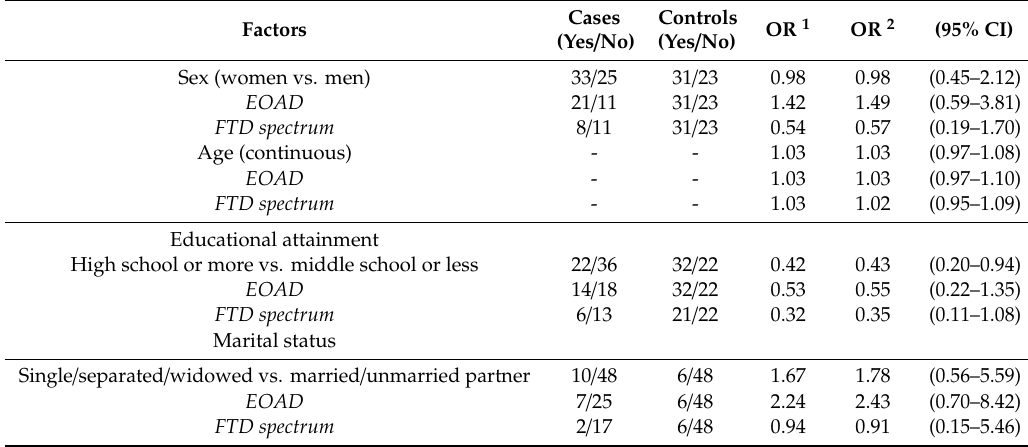
Table 3. Odds ratios (OR) with 95% confidence intervals (CIs) for early-onset dementia (EOAD, early-onset Alzheimer’s dementia; EOFTD, early-onset frontotemporal dementia) related to sociodemographic characteristics.